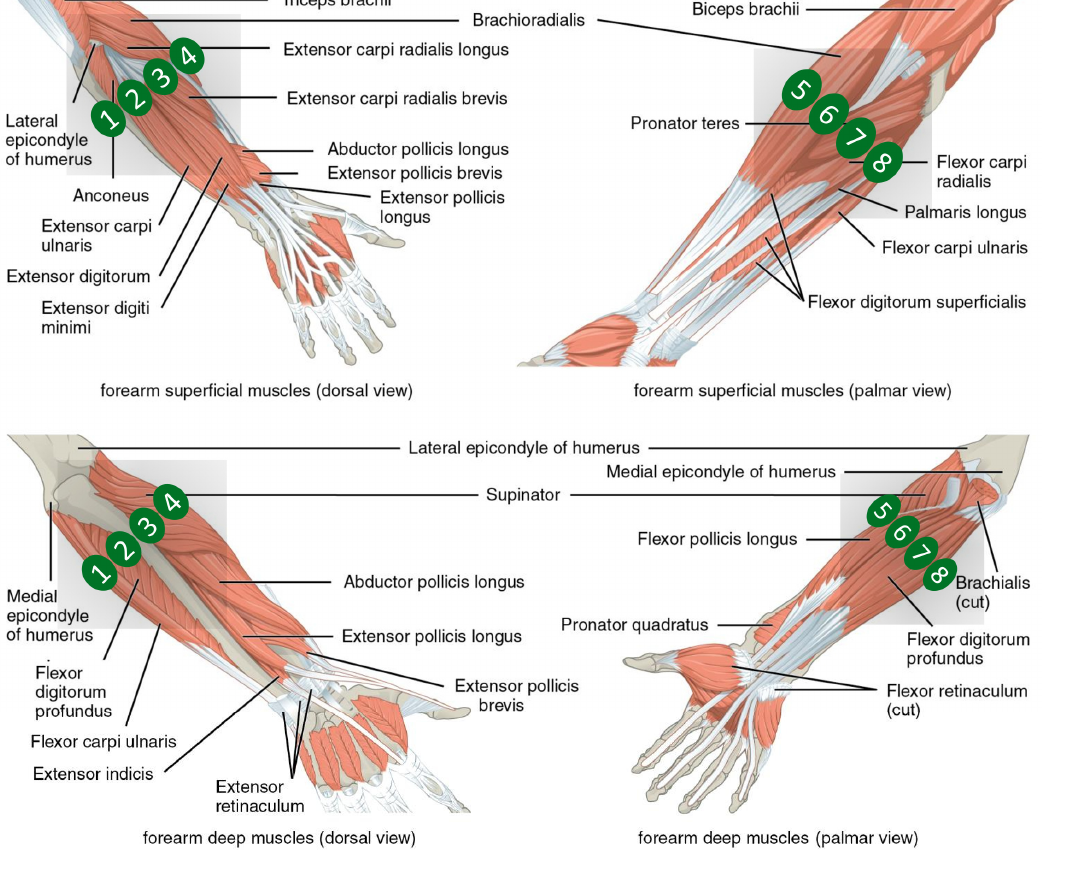
Figure 2. Positioning of the electrodes and underlying specific muscles. The image was adapted using file licensed under the Creative Commons Attribution 4.0 International license (Picture was adapted using